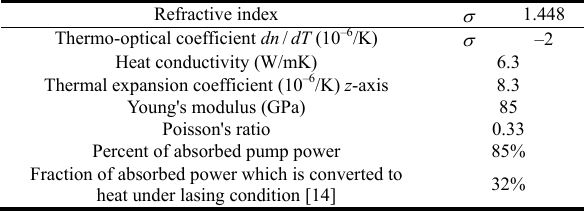
Table 1 Nd: YLF parameters used in the finite-element analysis [18].